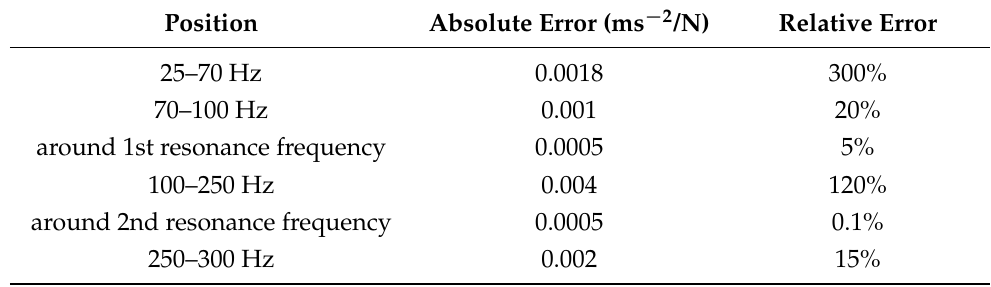
Table 3. Errors in Figure 9.